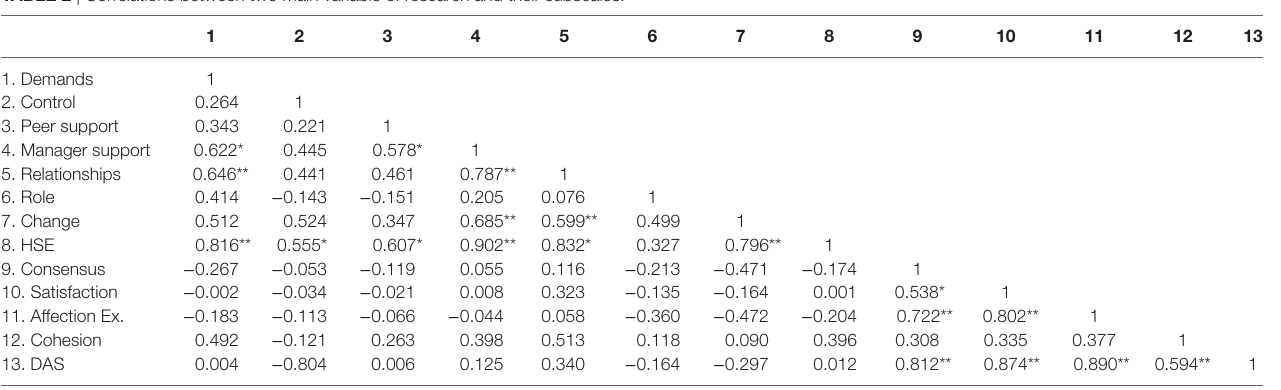
TaBle 2 | Correlations between two main variable of research and their